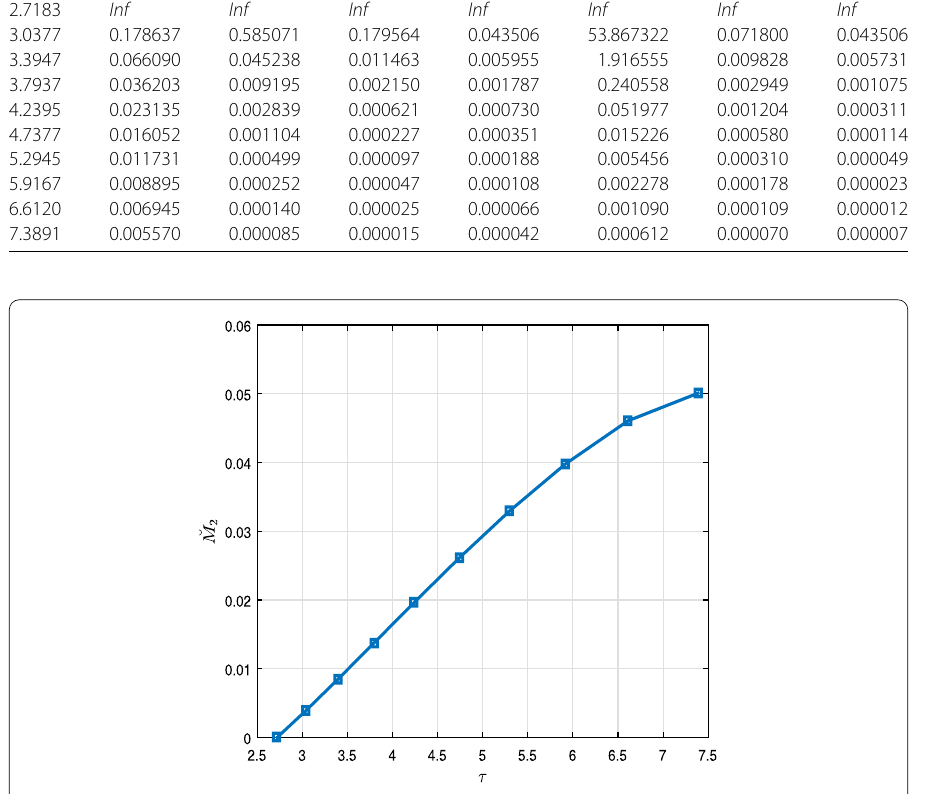
Figure 1 2D-graph of ˘ M 2 for τ ∈ [ e , e 2 ] in Example